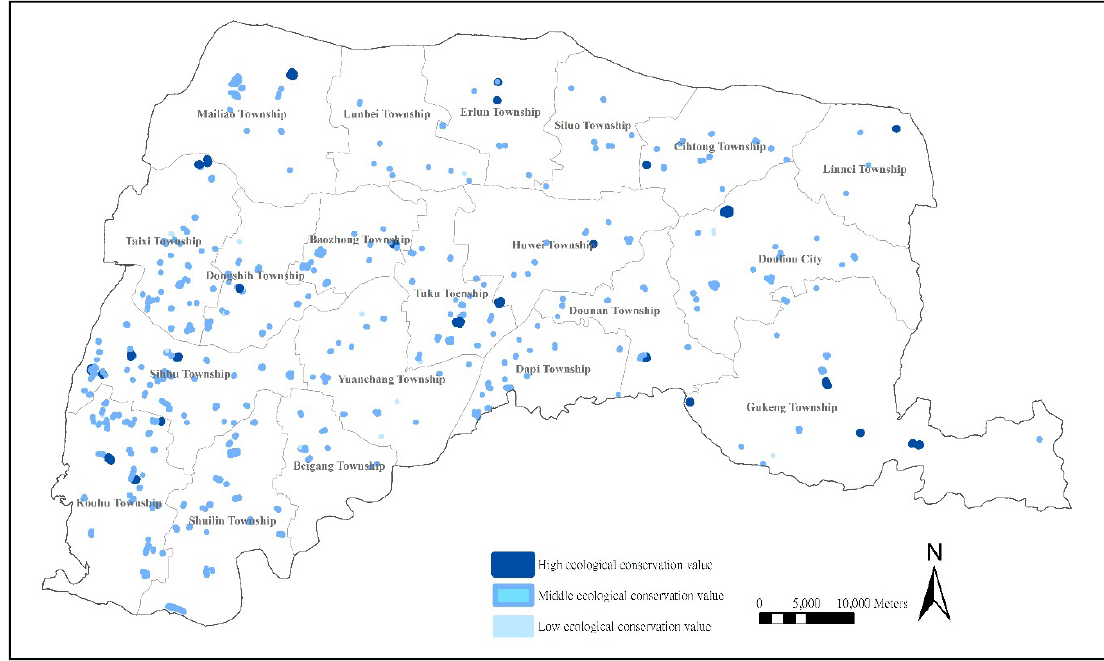
Figure 4. Distribution of farm ponds with ecological preservation